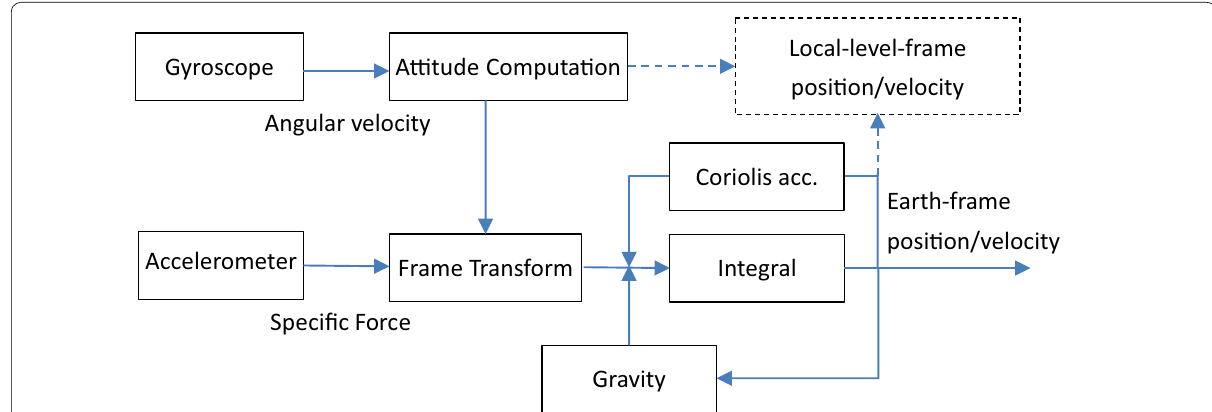
Fig. 1 Earth-frame inertial navigation mechanization (with possible information display in local-level frame, as indicated by dashed lines and